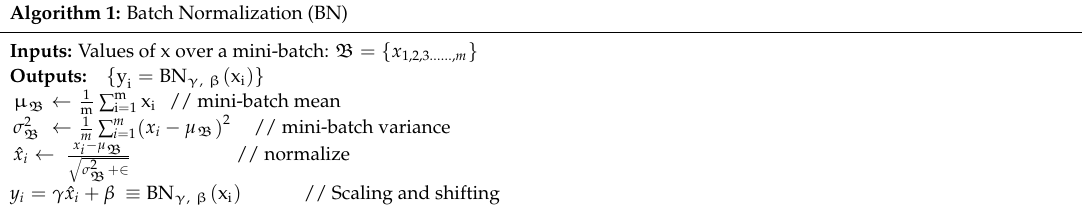
Algorithm 1: Batch Normalization